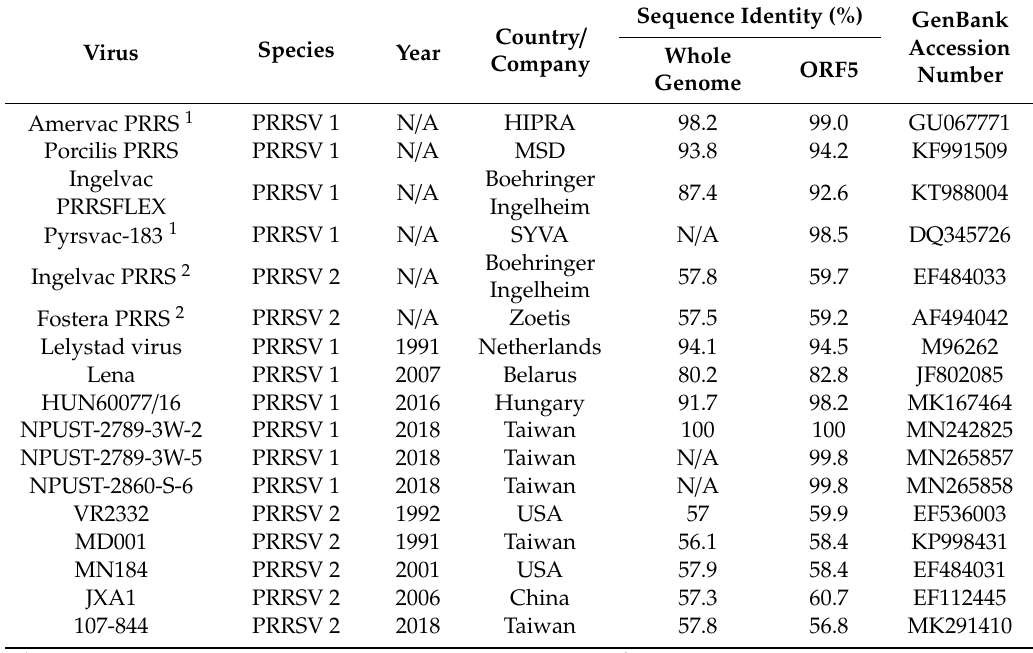
Table 1. Sequence identity of PRRSV / NPUST-2789-3W-2 / TW / 2018 and the reference